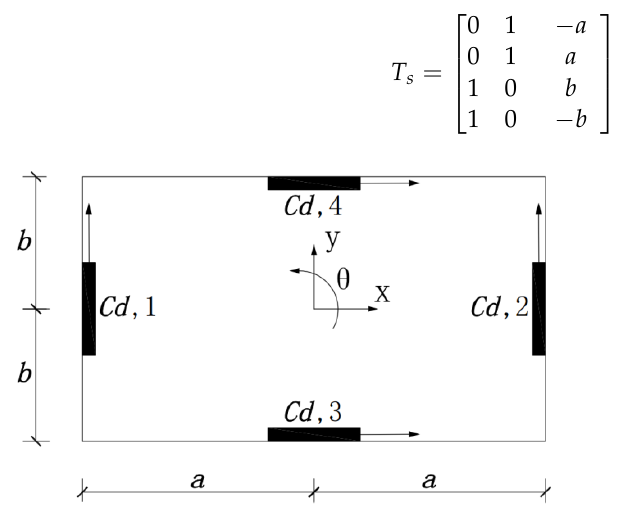
Figure 1. Structural plane with dampers. The rows T s in the matrix represent the positions of the dampers numbered C d ,1 ∼ C d ,4 , and the columns represent the displacements in the x , y , and θ directions, and